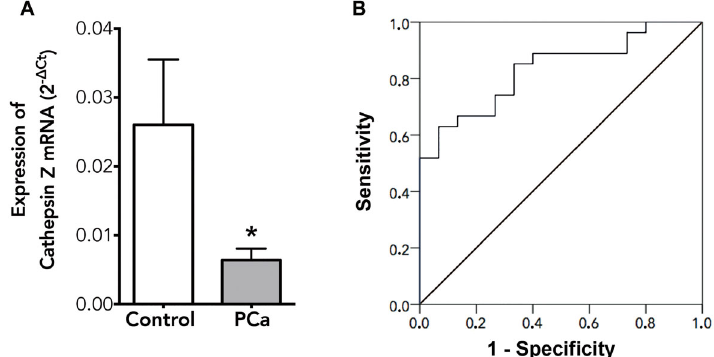
Figure 2. A , Relative expression of cathepsin Z (CTSZ) mRNA in the blood of patients with prostate cancer (PCa) before treatment compared with healthy subjects (control) determined by real-time polymerase chain reaction (qPCR). Data are reported as means ± SD. *P=0.002 ( t -test). B , Receiver operating characteristic (ROC) curve of CTSZ mRNA as a molecular marker of PCa, with an area under the curve (AUC) of 0.832 ± 0.062, P o